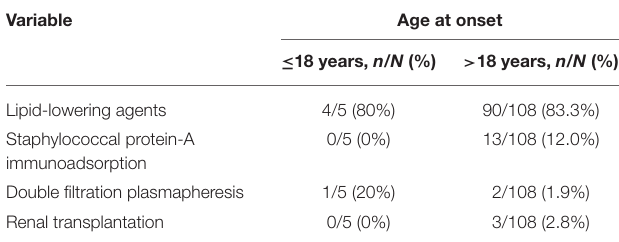
TABLE 3 | Treatment strategy of Chinese LPG patients.